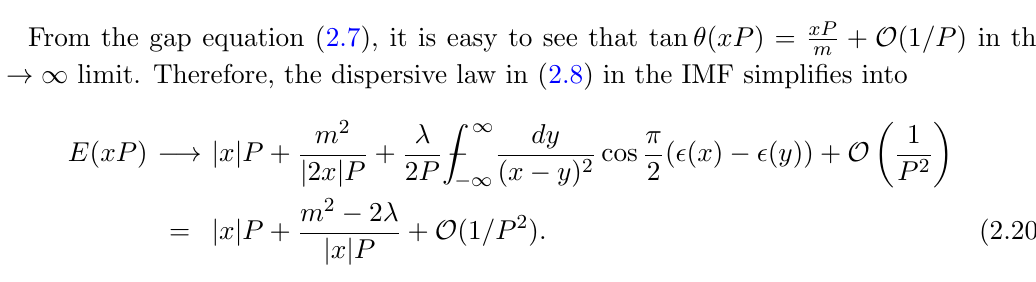
Figure 4 . The C and S functions viewed in various reference frames. As a concrete example, here we generate the Bogoliubov angle for the massless u